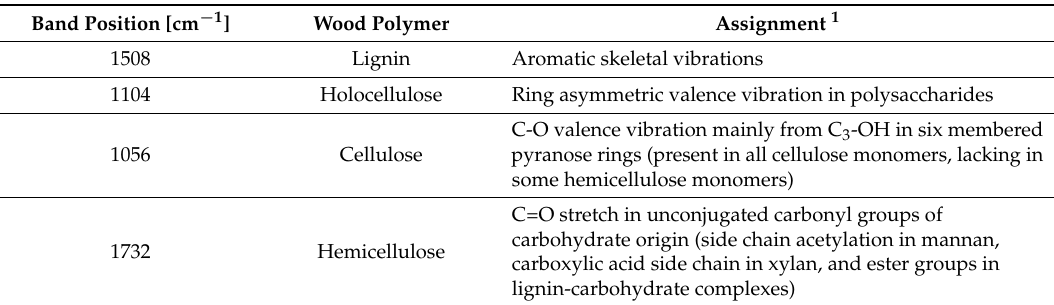
Table 1. Assignment of the four absorbance bands used for calculating five band area ratios to determine quantitative compositional changes between annual